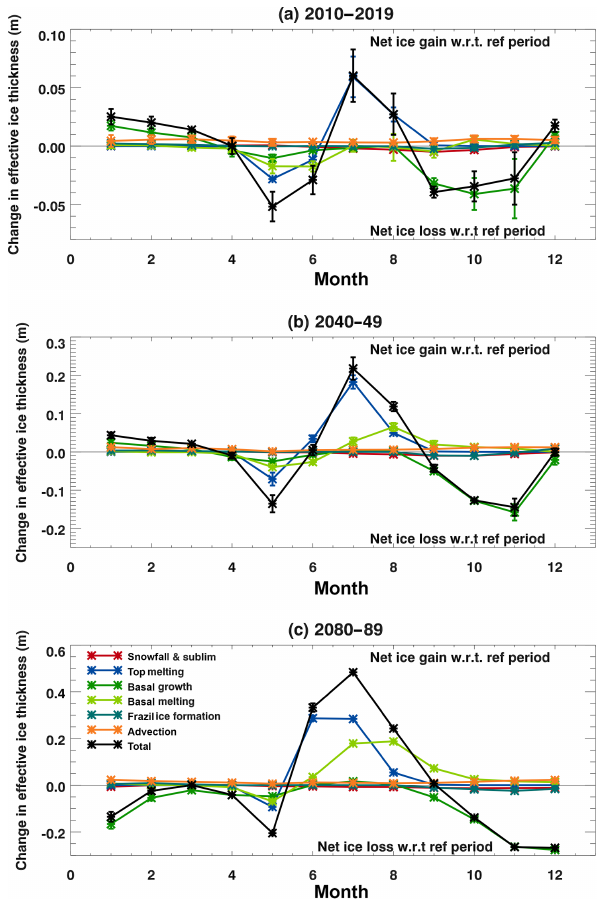
Figure 6. Ensemble mean seasonal cycles of the sea ice volume budget components as defined in Sect. 3.1 for the HadGEM2- ES Hist + RCP8.5 integrations, averaged over the region defined in Fig. 2 and plotted as differences relative to the mean over the ref- erence period 1960–1989. Values are ensemble means ± 1 standard deviation, and positive values correspond to net ice gain with re- spect to the reference period: (a) 2010–2019, (b) 2040–2049, and (c) 2080–2089. Note that the plots have different vertical